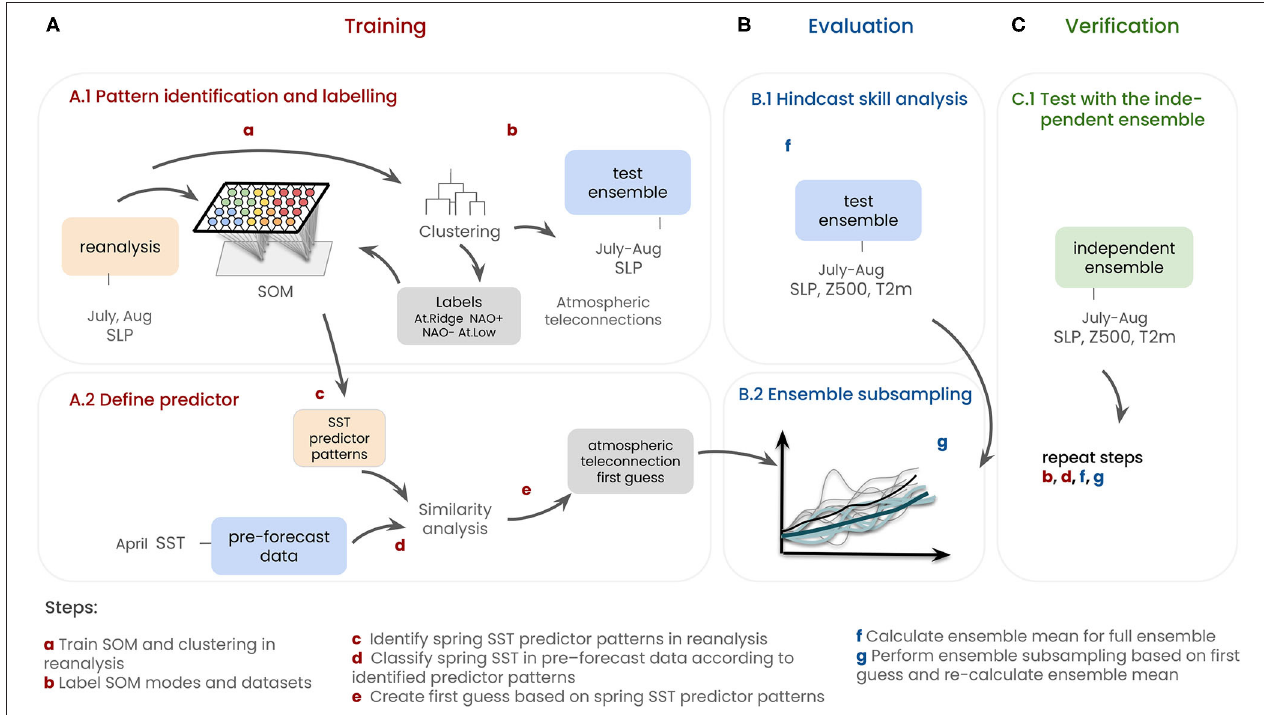
FIGURE 1 | Sketch of workflow. A.1 : We use Self-Organizing Map (SOM) to identify atmospheric teleconnections dominating the large-scale variability over the Euro-Atlantic region in 1902–2008. The final SOM output is a map consisting of twelve SOM modes. We train SOM with monthly July and August (JA) sea level pressure (SLP) in the reanalysis data. This same data is used to train a k-means clustering ( k = 4) to be used as a reference, whose centroids are labeled NAO + , NAO − , At. Ridge or At. Low as proposed in Cassou et al. (2005). A.2 : We calculate pattern correlation between SOM modes and the k-means centroids to associate each summer SOM mode to a summer atmospheric teleconnection. We repeat this process with the k-means centroids to label each JA SLP field of the reanalysis and the hindcast. Finally, we identify sea surface temperature (SST) predictor patterns by calculating composite April SST patterns in the reanalysis with respect to SOM modes. Those SST predictor patterns are used to classify each North Atlantic April SST field in the pre-forecast data using pattern correlation. Given that each SST predictor pattern precedes a summer SOM mode associated with NAO + , NAO − , Atlantic Ridge (At. Ridge) or Atlantic Low (At. Low), we are able to define a summer atmospheric teleconnection “first guess” before each initialization. B.1 : Using the test ensemble, we evaluate the hindcast skill for 3–4 month lead time considering the full ensemble to calculate the ensemble mean. B.2 : We perform ensemble subsampling to re-calculate the ensemble mean by selecting only ensemble members whose labels agree with the “first guess,” and comparing it with the full ensemble. C.1 : We label, classify, and subsample the independent ensemble as verification of our